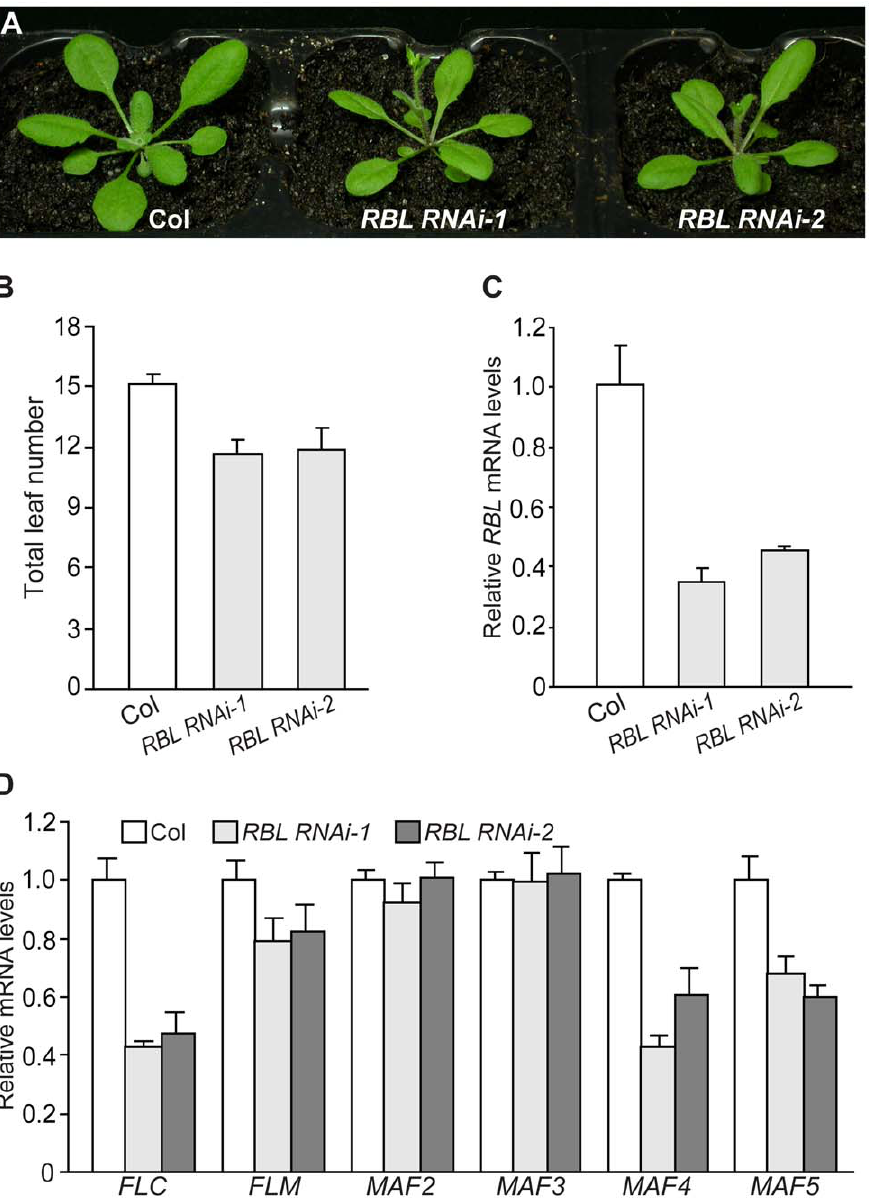
Figure 2. RBL Represses the Floral Transition in Arabidopsis . (A) Phenotypes of RBL RNAi lines grown in long days (LD). Col was used as the parental accession in RBL knockdown. (B) Flowering times of the RBL RNAi lines grown in LD. The total number of primary rosette and cauline leaves formed prior to bolting was counted, and 11–12 plants were scored for each line. Error bars indicate standard deviations (SD). (C) Relative RBL mRNA levels in seedlings of the RBL RNAi lines determined by real-time quantitative PCR. Relative expression to parental Col is presented. Bars indicate SD. (D) Relative mRNA levels of FLC and FLC homologs in RBL RNAi seedlings quantified by real-time PCR.